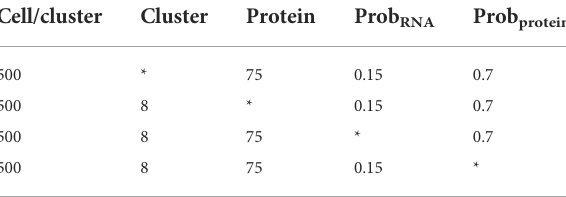
TABLE 1 Simulation data settings for all experiments; each cluster contains 500 cells; ‘ * ’ refers to the variable parameter. Cell/cluster Cluster Protein Prob